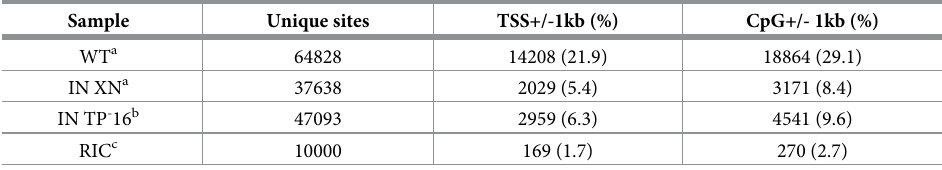
Table 2. Comparison of integration sites in 293mCAT cells of MLV IN XN and MLV IN TP - derived from TP - 16